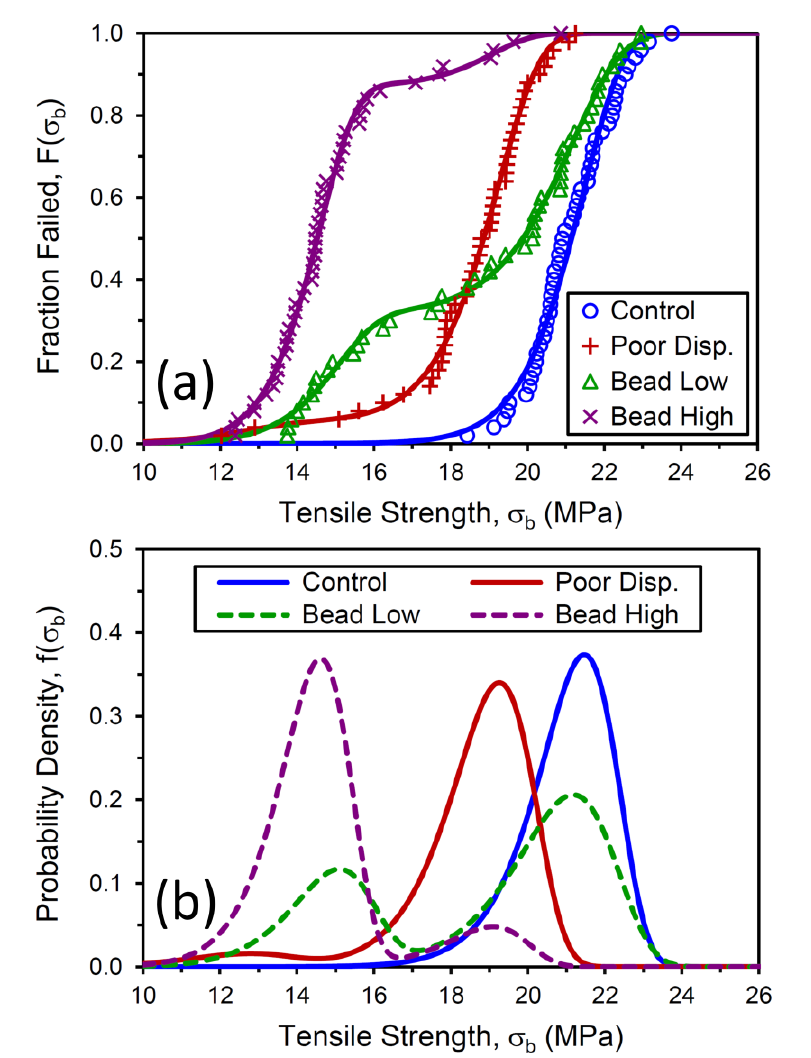
Figure 6. Measured tensile strength distributions for the four compounds (symbols) and Weibull cumulative distribution function fits (lines) ( a ). Associated Weibull probability density functions ( b ).